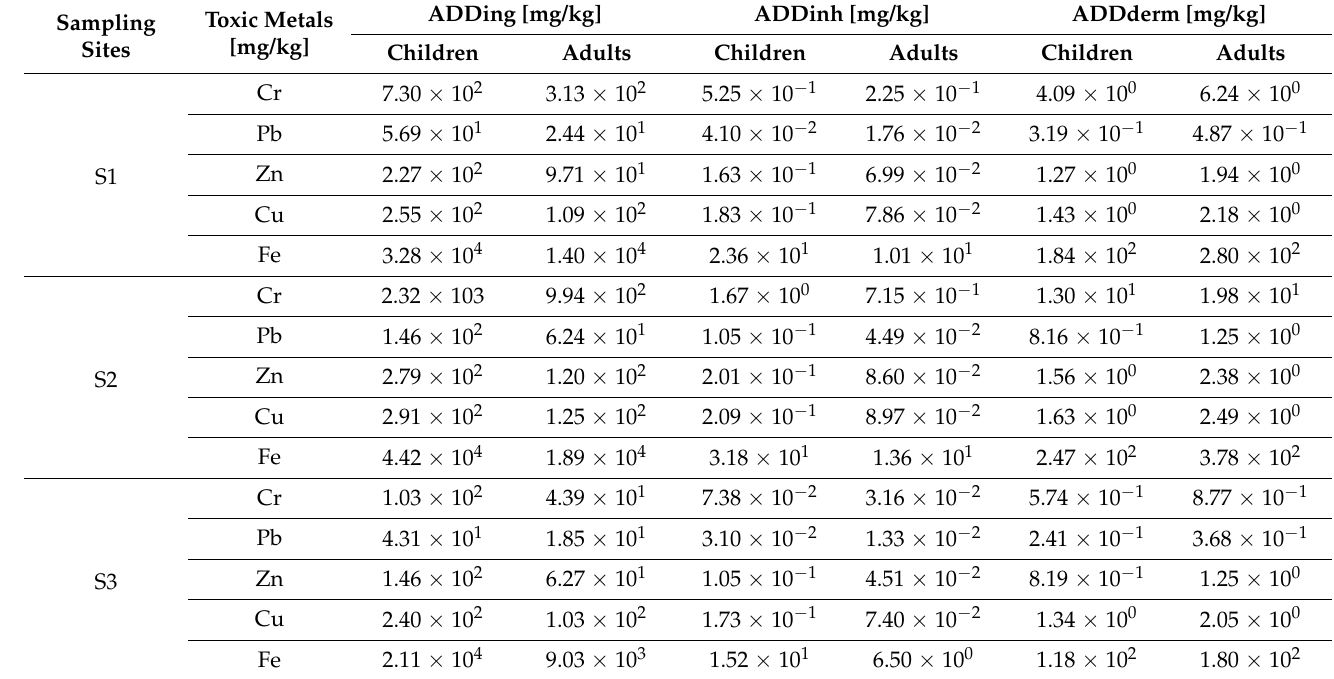
Table 8. ADD values [mg/kg] for the sediments at all the studied sites: S1 “Bł˛ekitna Laguna”, S2 “Huta”, and S3 “Mała